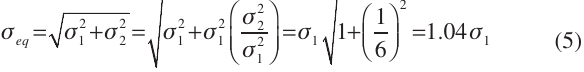
Table 1 and Figure 21 present the comparison between